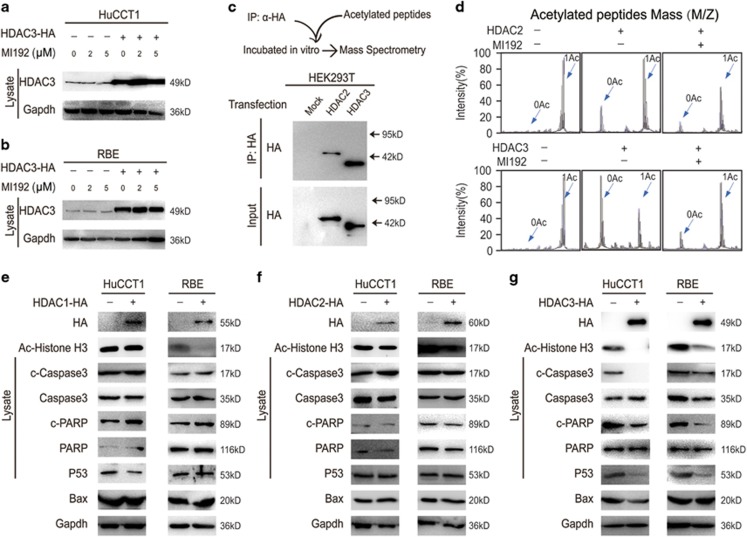
HDAC3 is the direct target of MI192. (a and b) HDAC3-overexpressing cells were treated with MI192 and subjected to western blot. (c) Schematic diagram of the in vitro deacetylation assay with HDAC3 (top). The immunoprecipitated protein corresponding to HDAC-HA was subjected to western blot (bottom). (d) The HDAC protein was incubated with acetylated peptides with or without MI192, and the rate of deacetylation was determined using mass spectrometry (MS). (e) HDAC1-overexpressing cells and their counterparts were subjected to western blot. (f) HDAC2-overexpressing cells and their counterparts were subjected to western blot. (g) HDAC3-overexpressing cells and their counterparts were subjected to western blot. Data represent the mean±S.E.M., n≥3. *P<0.05 and **P<0.01; NS not significant